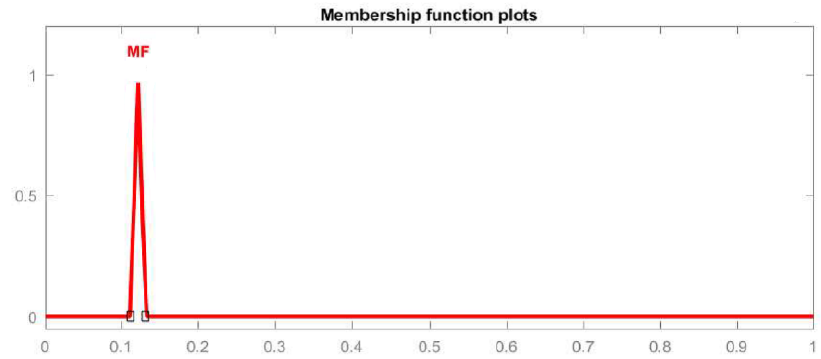
Figure 5. Membership function of R 2 ( α ) for consecutive system.